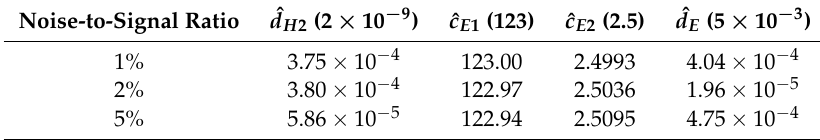
Table 7. Performance of proportional–derivative controller optimization strategy for the hydraulic engine mount system with measurement noise (experimental parameter values shown in